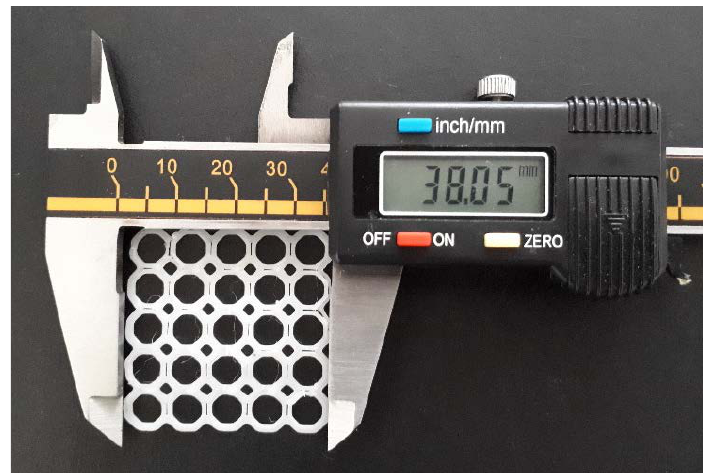
Figure 1. Digital image of the 3D printed PCL scaffold measured with a digital caliper.